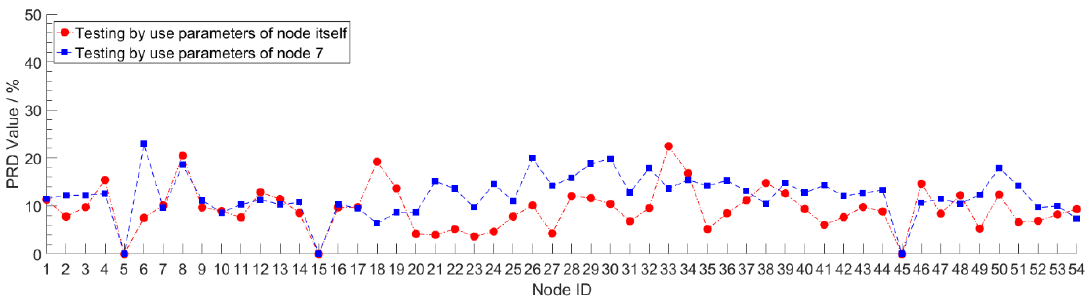
Figure 9. The PRD value of each node on testing with different model parameters.